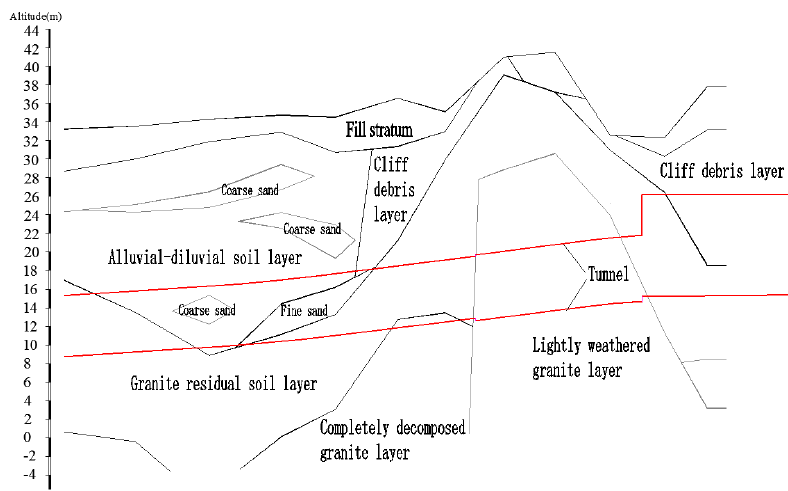
Figure 1. Vertical geological section of the tunnel project.